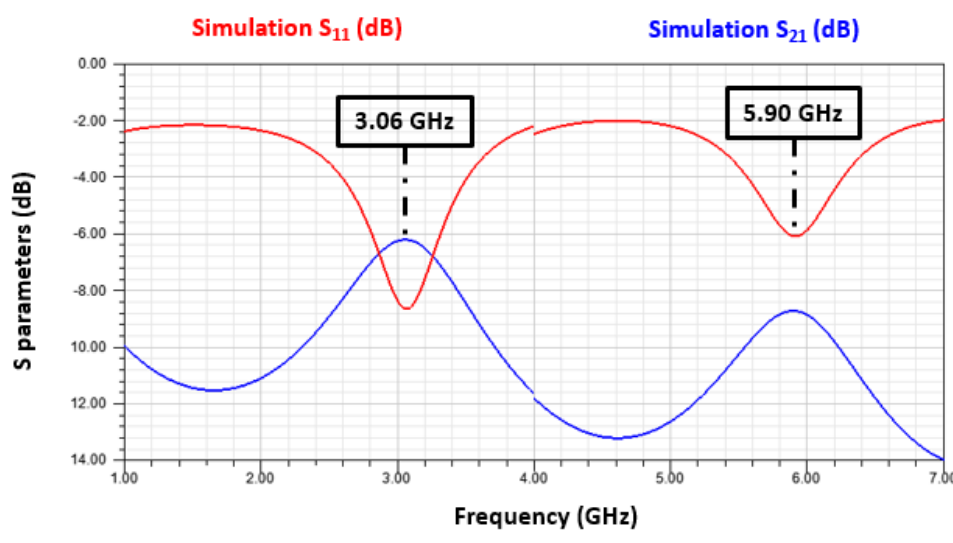
Figure 5. Simulation of the gas sensor’s electrical behavior. (Reference resonator).